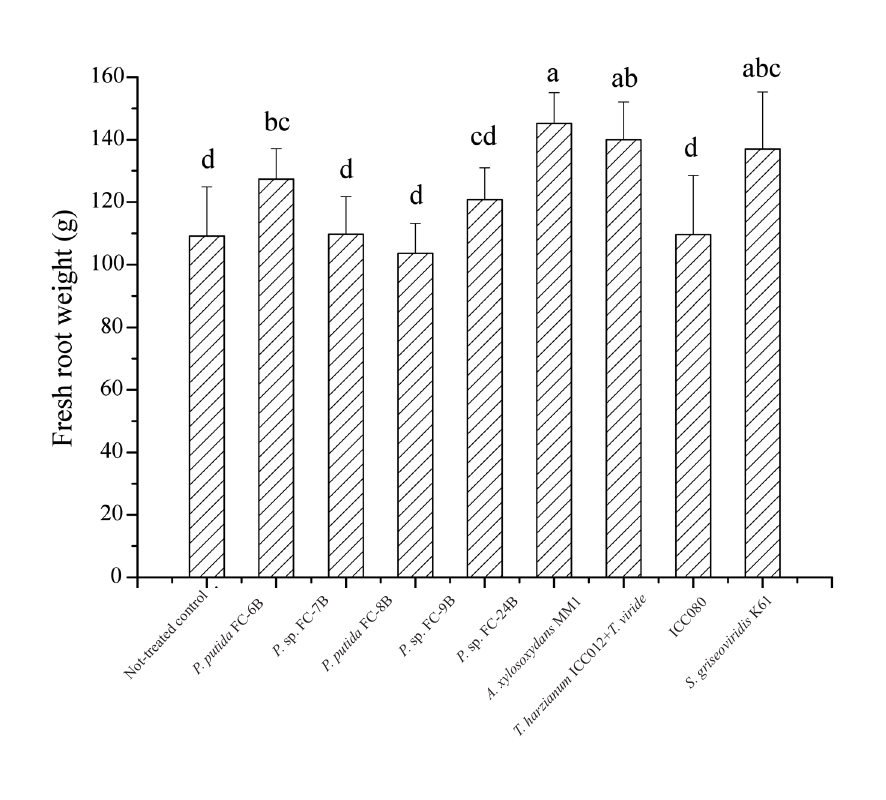
Figure 4. Root growth promoting activity of biocontrol agents on tomato in the absence of the pathogen 52 days after transplanting. Vertical bars represent the standard error of 6 replicates (two trials, 4 and 5). Means designated by the same letter are not significantly different ( P <0.05) according to Duncan’s